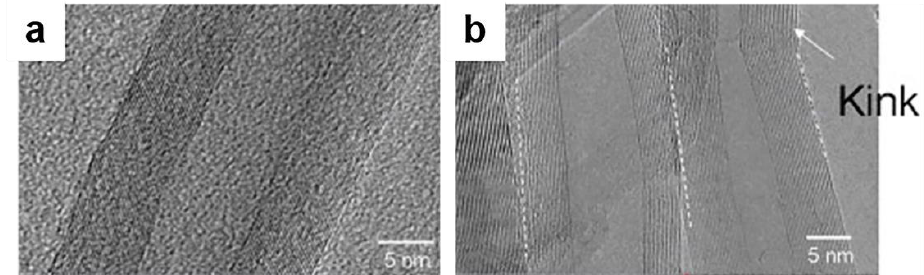
Figure 8. ( a ) HRTEM image of multi-shelled nanotube. ( b ) Multi-walled carbon nanotubes are welded together [68]. Copyright © 2021 Elsevier Ltd. and Carbon.